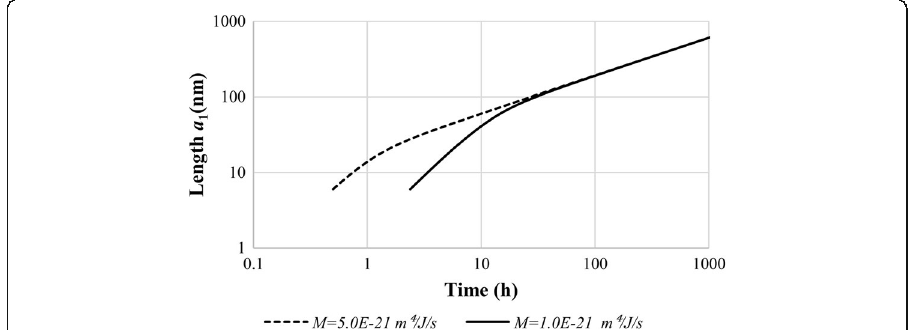
Fig. 3 Time evolution of the semi-axis length a 1 calculated using 2 different interfacial